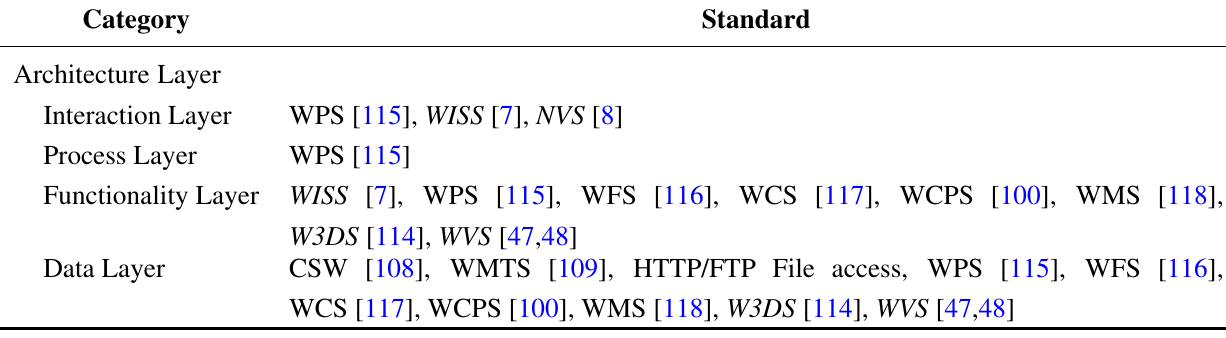
Table 4. Overview of a selection of relevant standards (regular font type) and standardization proposals (italic font type) for